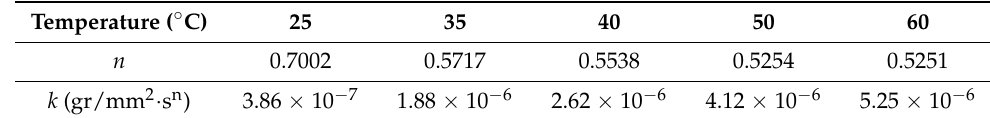
Figure 11. ( a ) Resin uptake vs. time for ABS, and ( b ) Ln( M *) vs. Ln( t ) based on Equations (7) and (8). Table 1. Empirical rate constant ( k ), and transport exponent ( n ) for ABS-UPR at different tempera- tures.